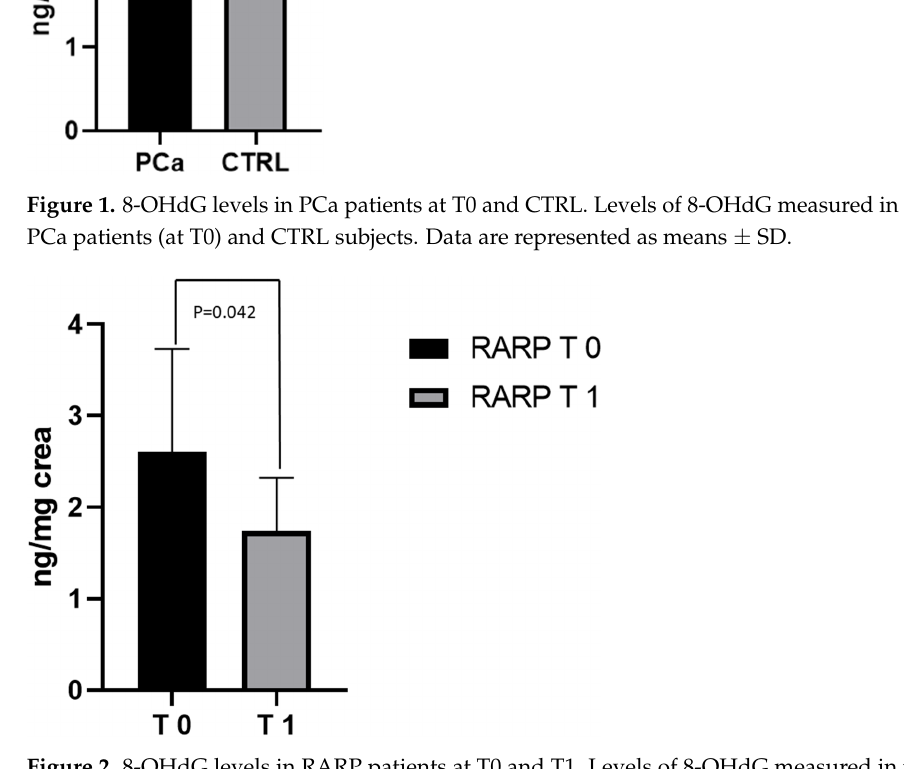
Figure 2. 8 ‐ OHdG levels in RARP patients at T0 and T1. Levels of 8 ‐ OHdG measured in urine from RARP patients at T0 and T1. Data are represented as means ± SD.